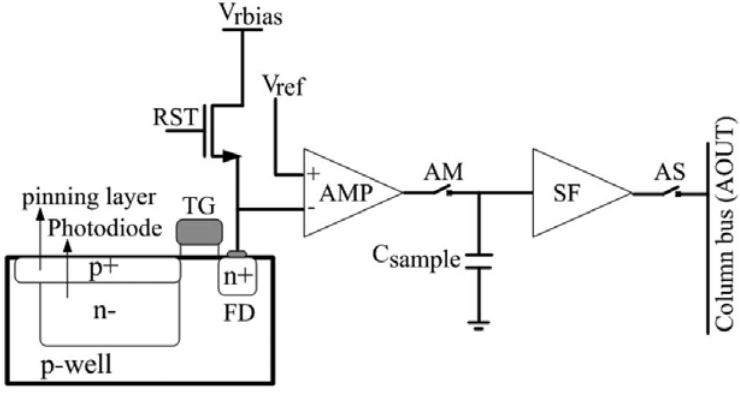
Figure 5. Simplified pixel architecture [80] (V V : Voltage reference for Buffer amplifier, RST: Reset transistor, TG: Transfer gate, FD: ref Floating diffusion, AMP: Buffer amplifier, AM: switch, C Source follower, AS: